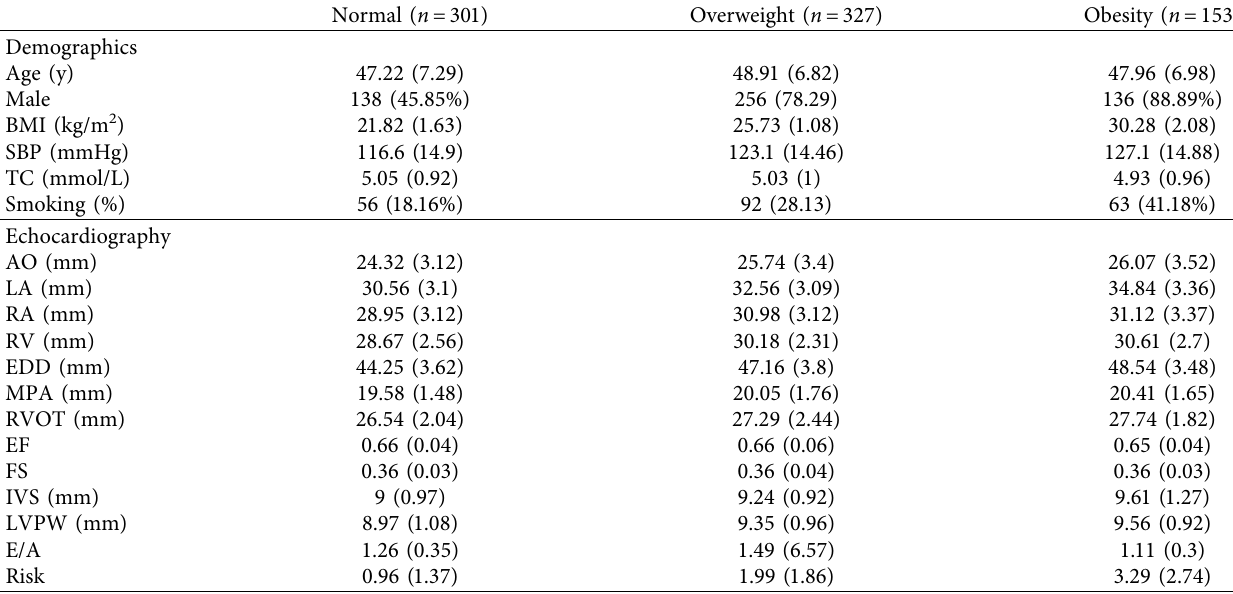
Table 2: Comparison of baseline characteristics and cardiac ultrasound parameters in the population undergoing SCORE system scoring. Normal ( n � 301) Overweight ( n �